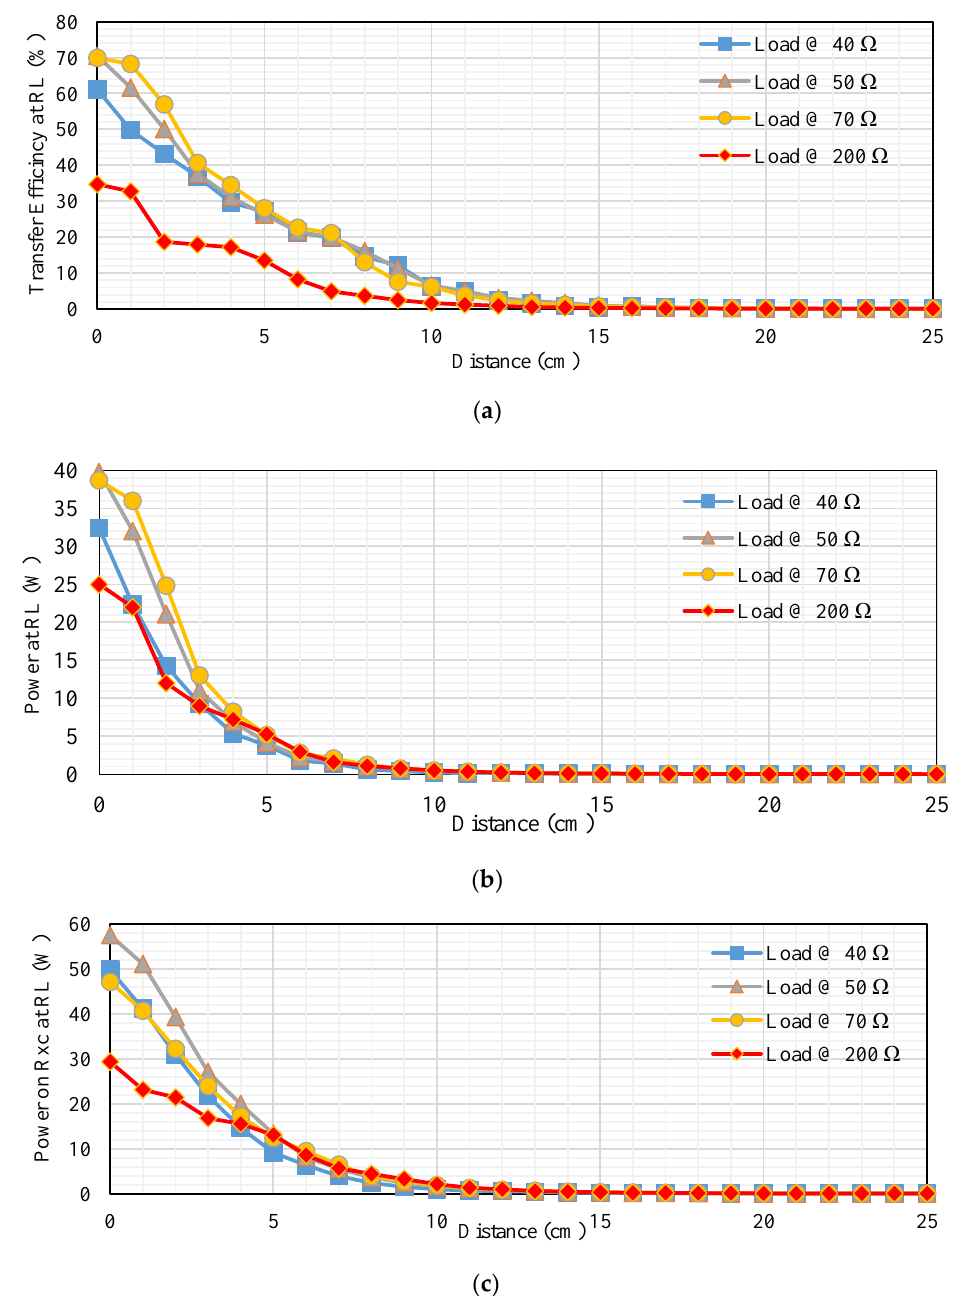
Figure 11. Performance at different loads for first topology: ( a ) transfer efficiency at different loads (RL), ( b ) transfer power at RL, and ( c ) transfer power on Rx C at RL.